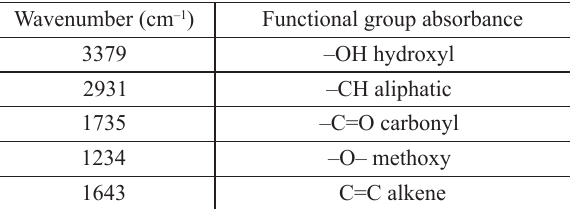
Determination of the main functional group